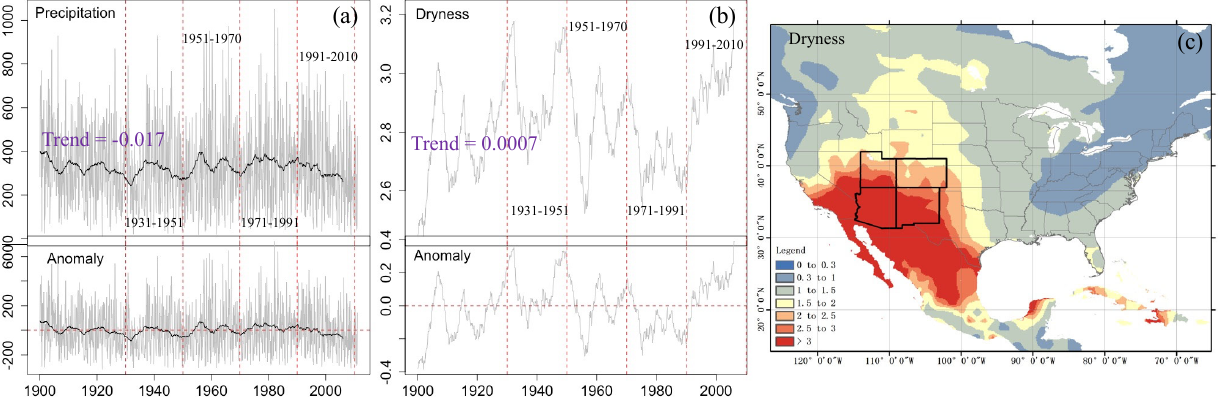
Figure 3. Climatological setting of the southern Intermountain region (from ERA-20C): ( a ) area averaged monthly mean precipitation (in mm/year) time series (top) and anomalies with the seasonal cycle removed (bottom), both with 5–year moving averages (black line). ( b ) Area-averaged dryness ratio of net radiation over rainfall (D = N/P, 5–yr moving average), and ( c ) geographical distribution of dryness ratio. Note that linear regression trends are displayed in purple.